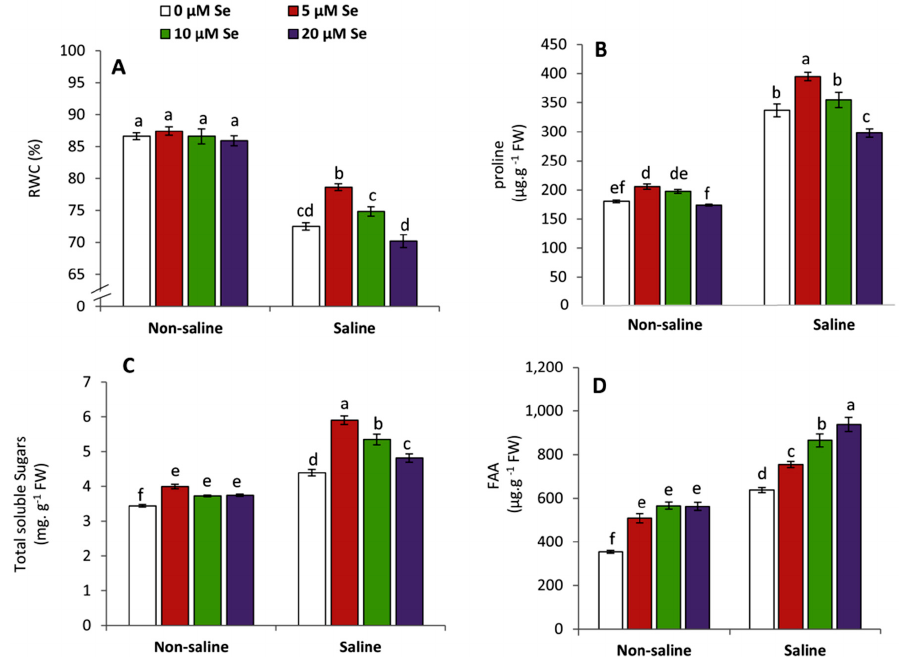
Figure 3. Effect of Se supplementation at 5, 10 and 20 µM on relative water content; RWC ( A ), proline ( B ), total soluble sugars ( C ) or free amino acids; FAA ( D ) of non-stressed and salt-stressed (50 mM NaCl) snap bean seedlings (28 days after sowing). The results are expressed as mean values of three measurements ± SE using Duncan’s multiple range test ( p = 0.05). Different letters indicate significant differences among the treatments.